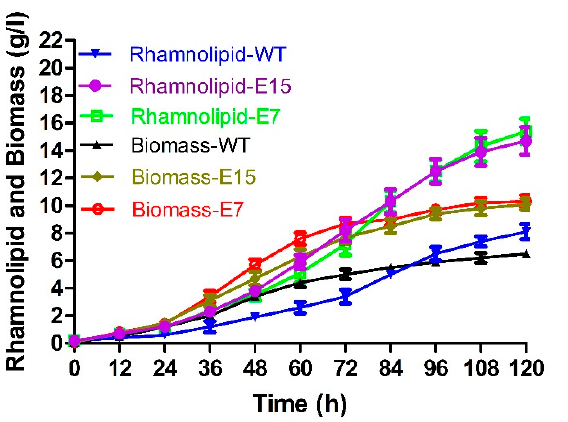
Figure 4. Rhamnolipid yield and biomass of strain E7, strain E15 and wild-type strain at pH 5.5.